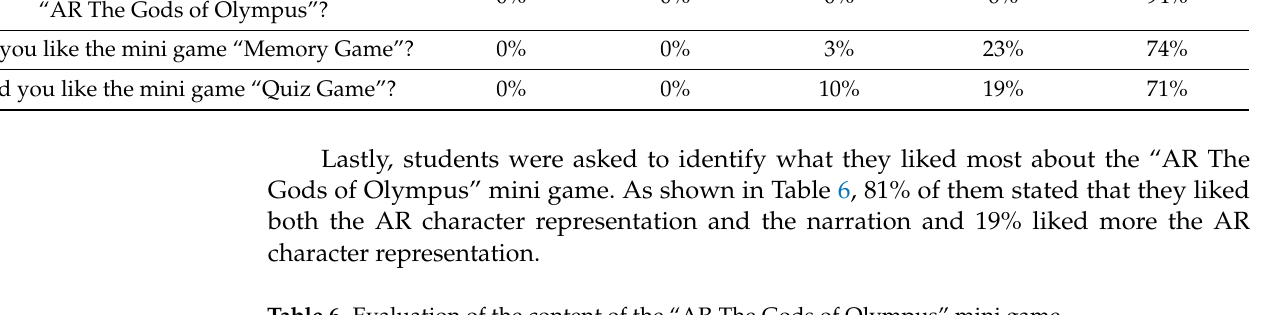
Table 6. Evaluation of the content of the “AR The Gods of Olympus” mini